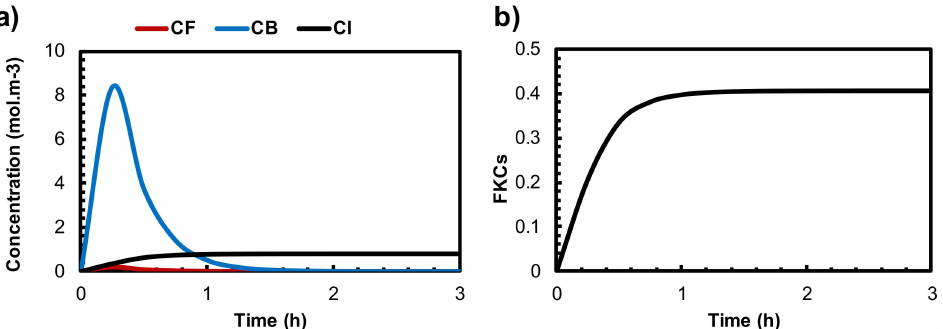
Figure 3. ( a ) The mean concentration of free, bound, and internalized drugs by the administration of conventional chemotherapy. ( b ) The FKCs during conventional